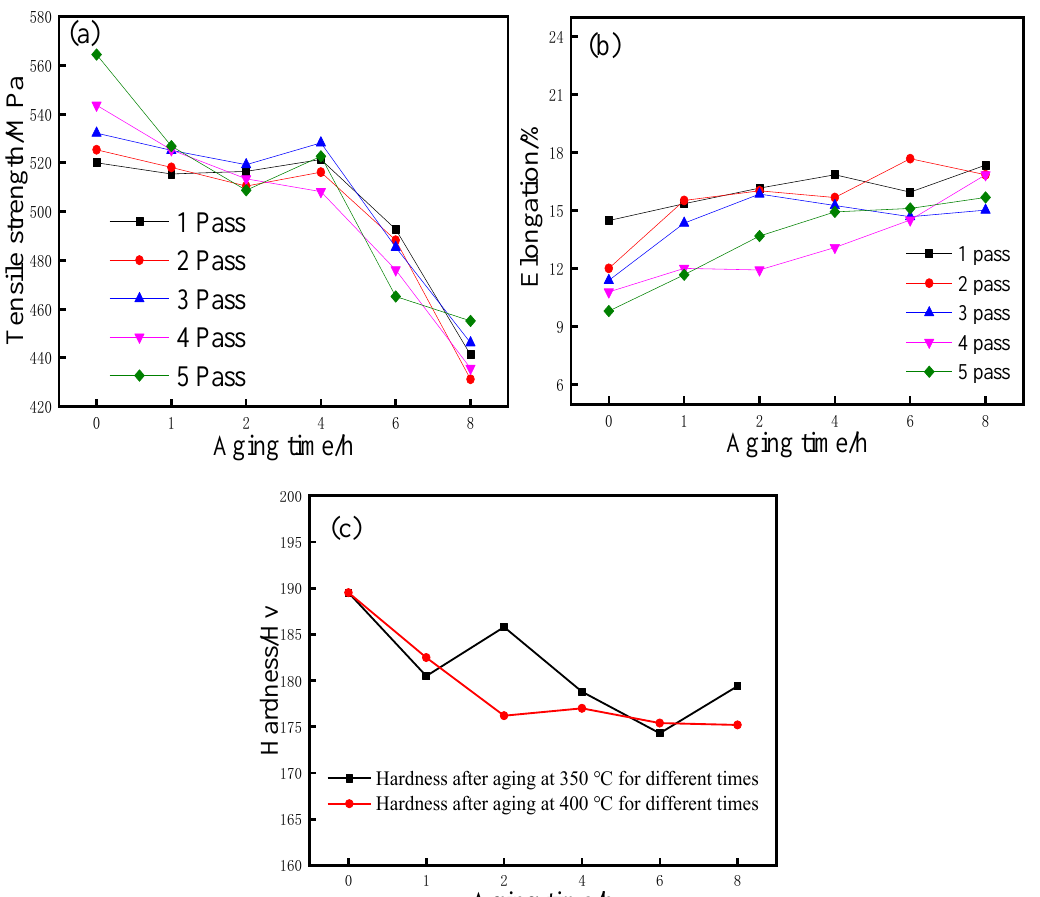
Figure 5. The Cu1.5Cr0.1Si alloy C-path deformation and aging at 350 °C for different times ( a ) strength ( b ) elongation ( c ) hardness.